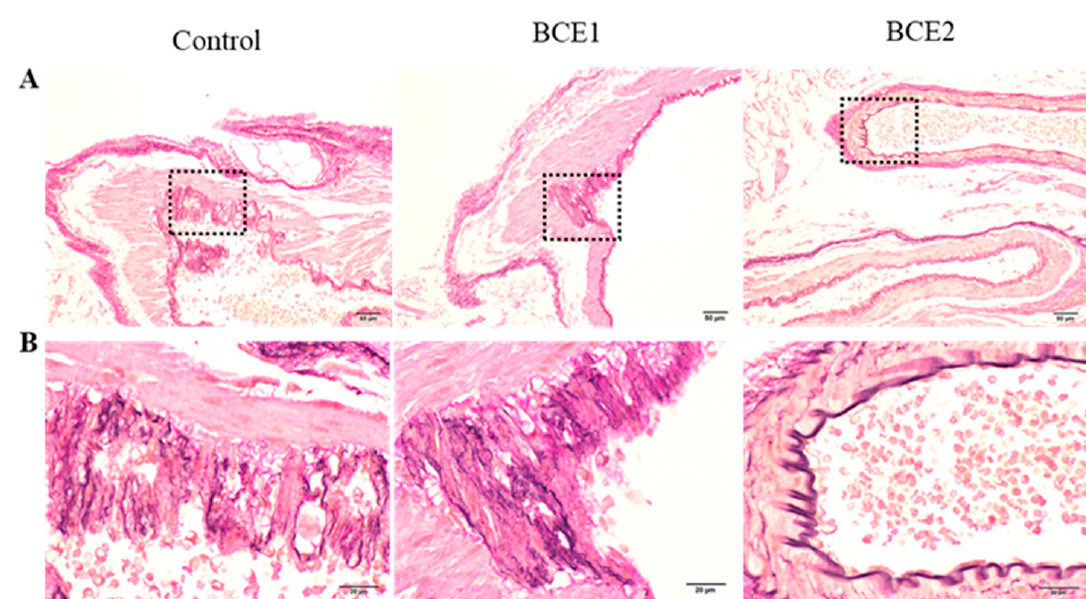
Figure 1. Representative images of foam cell uptake in the tunica intima obtained using Elastica van Gieson staining in the Control (high-fat diet without BCE), BCE1 (high-fat diet supplemented with 1% BCE powder), and BCE2 (high-fat diet supplemented with 3% BCE powder) groups. ( A ) Lower magnification image (100×, scale bar = 50 µm) and ( B ) higher magnification image of the boxed areas shown in panel A (magnification 400×, scale bar = 20 µm).